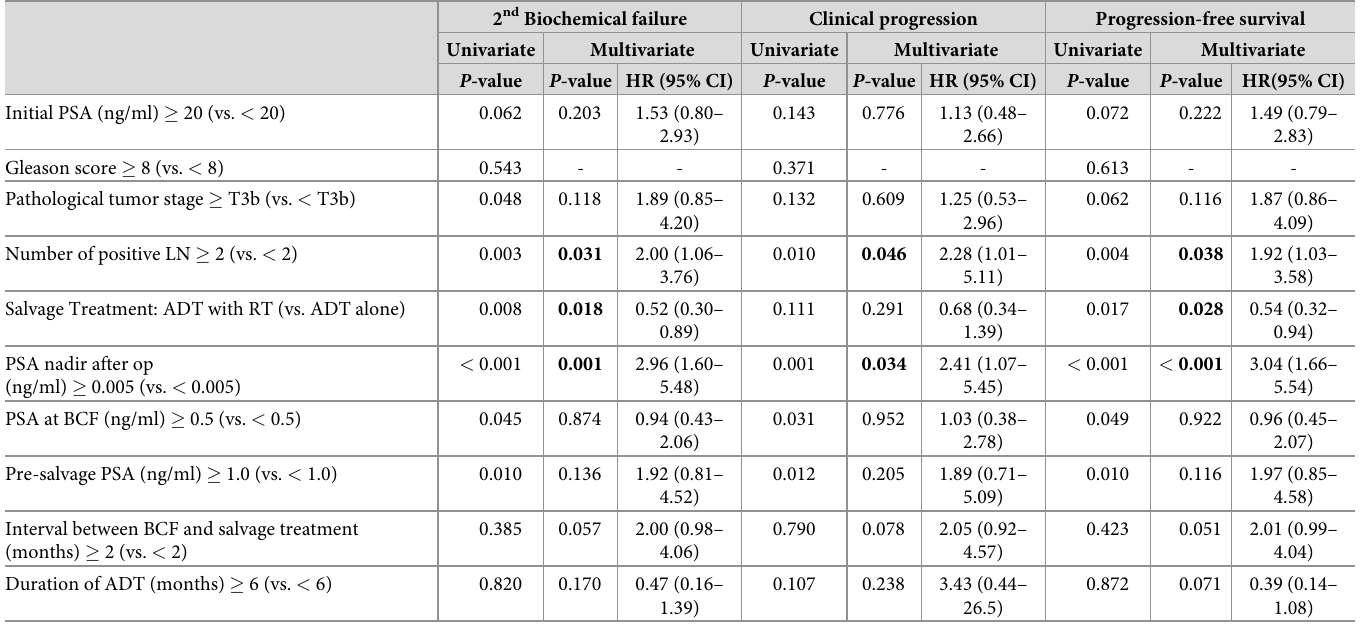
Table 3. Univariate and multivariate analysis of 2 nd biochemical failure, clinical progression, and progression-free survival after salvage treatment.